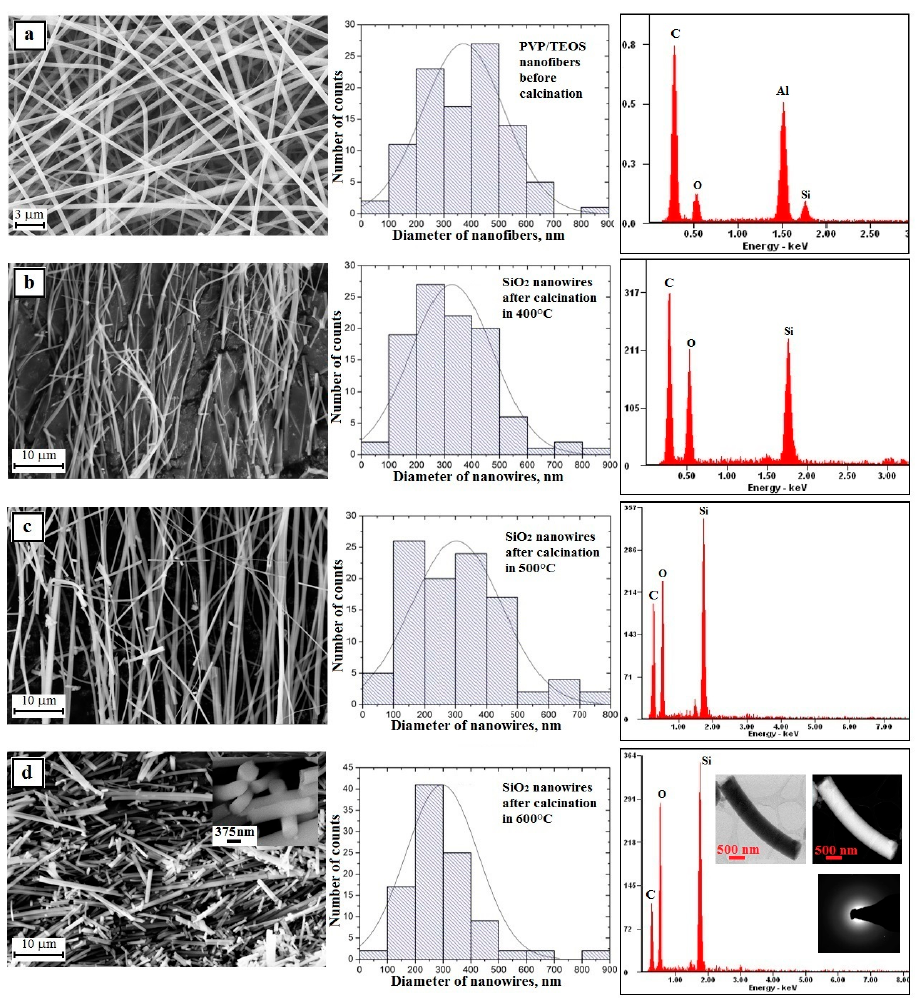
Figure 6. Left: SEM image of the topography on the surface of the formed fibrous composite mats, obtained nanowires; Middle: histograms presenting the distribution of hundredfold measurement of the diameter of randomly selected: ( a ) nanofibers obtained from PVP/TEOS/H 2 O/AcOH/EtOH solution, ( b – d ) SiO 2 nanowires after calcination in 400 ◦ C, 500 ◦ C, and 600 ◦ C; Right: obtained EDS spectra (peaks of Al derive from the substrate on which nanofibers were deposited while Au and Pd derive from the conductive layer sputtered onto the produce nanostructures) from the entire area shown in the SEM images and TEM images for SiO 2 nanowires obtained in 600 ◦ C including an image in a light and dark area with diffraction image from single